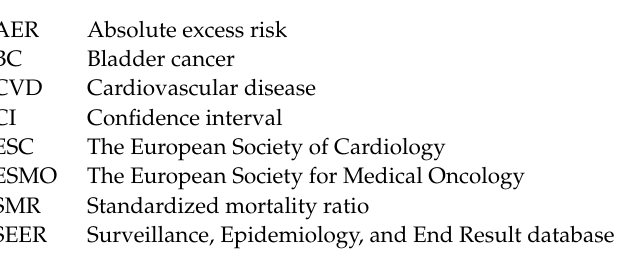
bladder cancer based on age at diagnosis; Table S1: The classifications about non-neoplasm causes of death; Table S2: Standardized mortality ratios for cardiovascular death in older patients with different subtypes of bladder cancer; Table S3: Absolute excess risks for cardiovascular death in older patients ( ≥ 65 years) with bladder